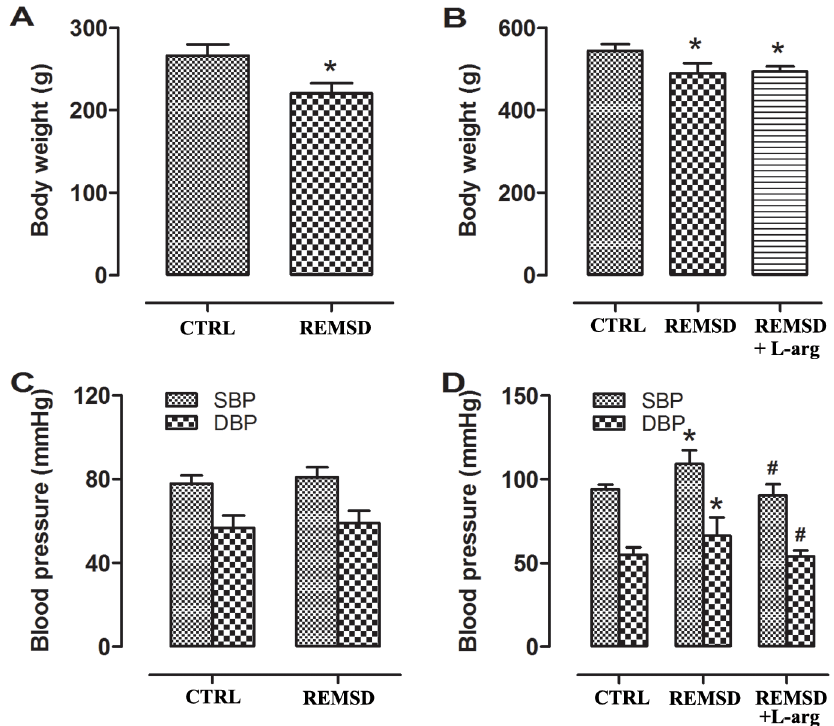
Fig 1. Body weights and blood pressures with or without REM sleep deprivation (REMSD). (A)Body weights of young-agedrats.(B)Body weightsof middle-agedrats (C)Bloodpressuresof young-agedrats.(D) Blood pressures of middle-aged rats.Data were expressed as means ± SEM; n = 6 rats per study group. * P < 0.05 vs . CTRL; # P < 0.05 vs .REMSD. CTRL refers to rats not subjectedto REM sleep deprivation. SBP, systolic blood pressure; DBP, diastolicblood pressure; L-arg, L-arginine.